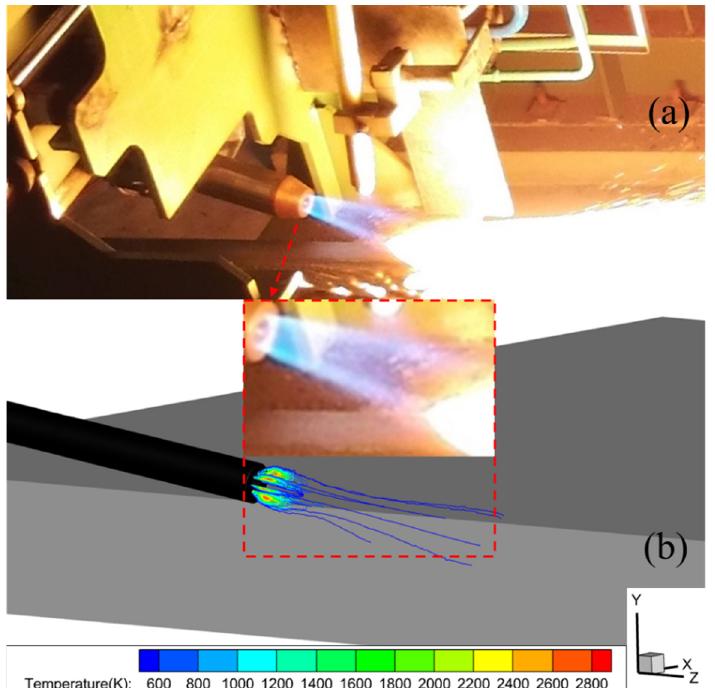
Figure 5. ( a ) Corner cleaning flame shape in factory; ( b ) The flame shape and temperature at the nozzle outlet.